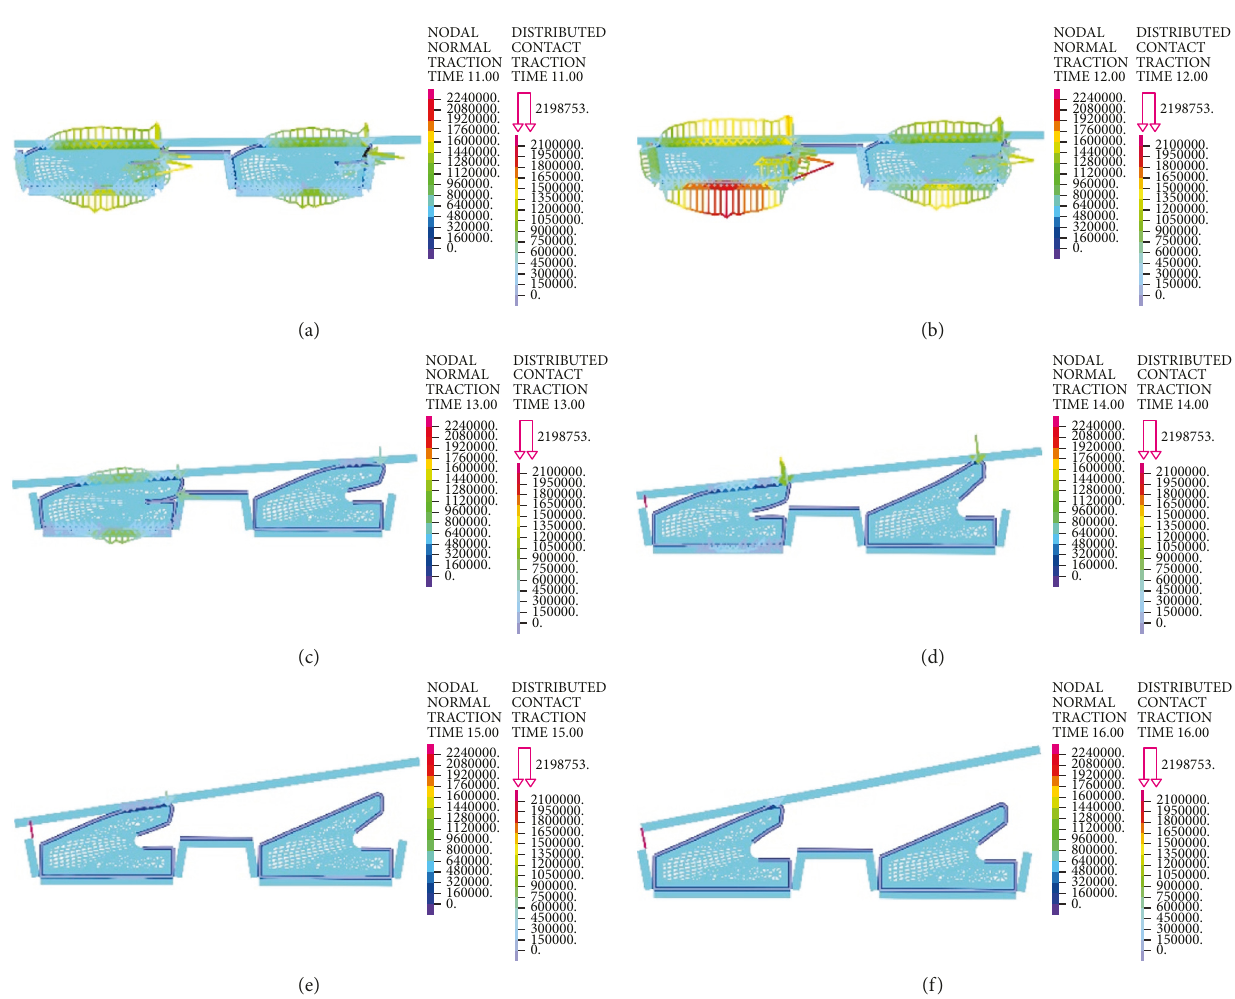
Figure 18: Contact stress distribution of the rubber rings after optimizing during rotation. (a) Deflection 0.2 ° . (b) Deflection 0.4 ° . (c) Deflection 0.6 ° . (d) Deflection 0.8 ° . (e) Deflection 1.0 ° . (f) Deflection 1.2 °